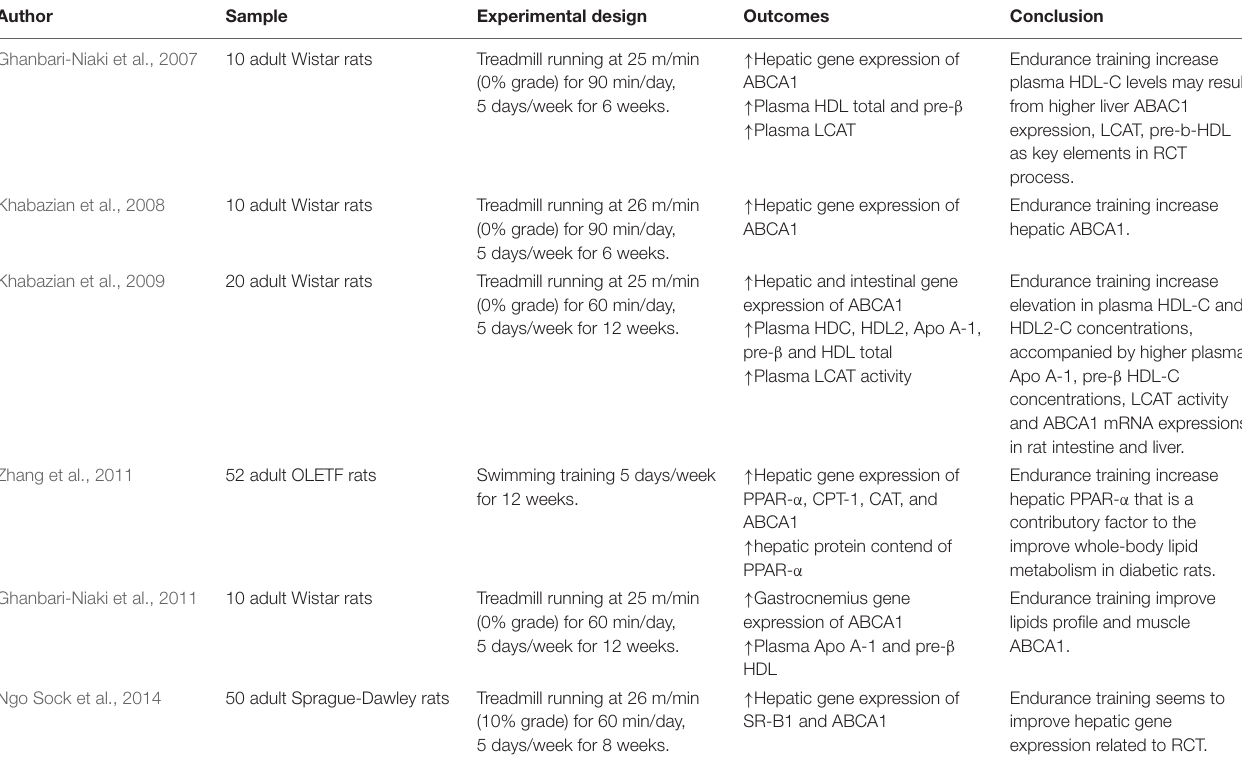
TABLE 2 | Summary of the effects of training strategies on lipids profile and RCT pathway in animals.